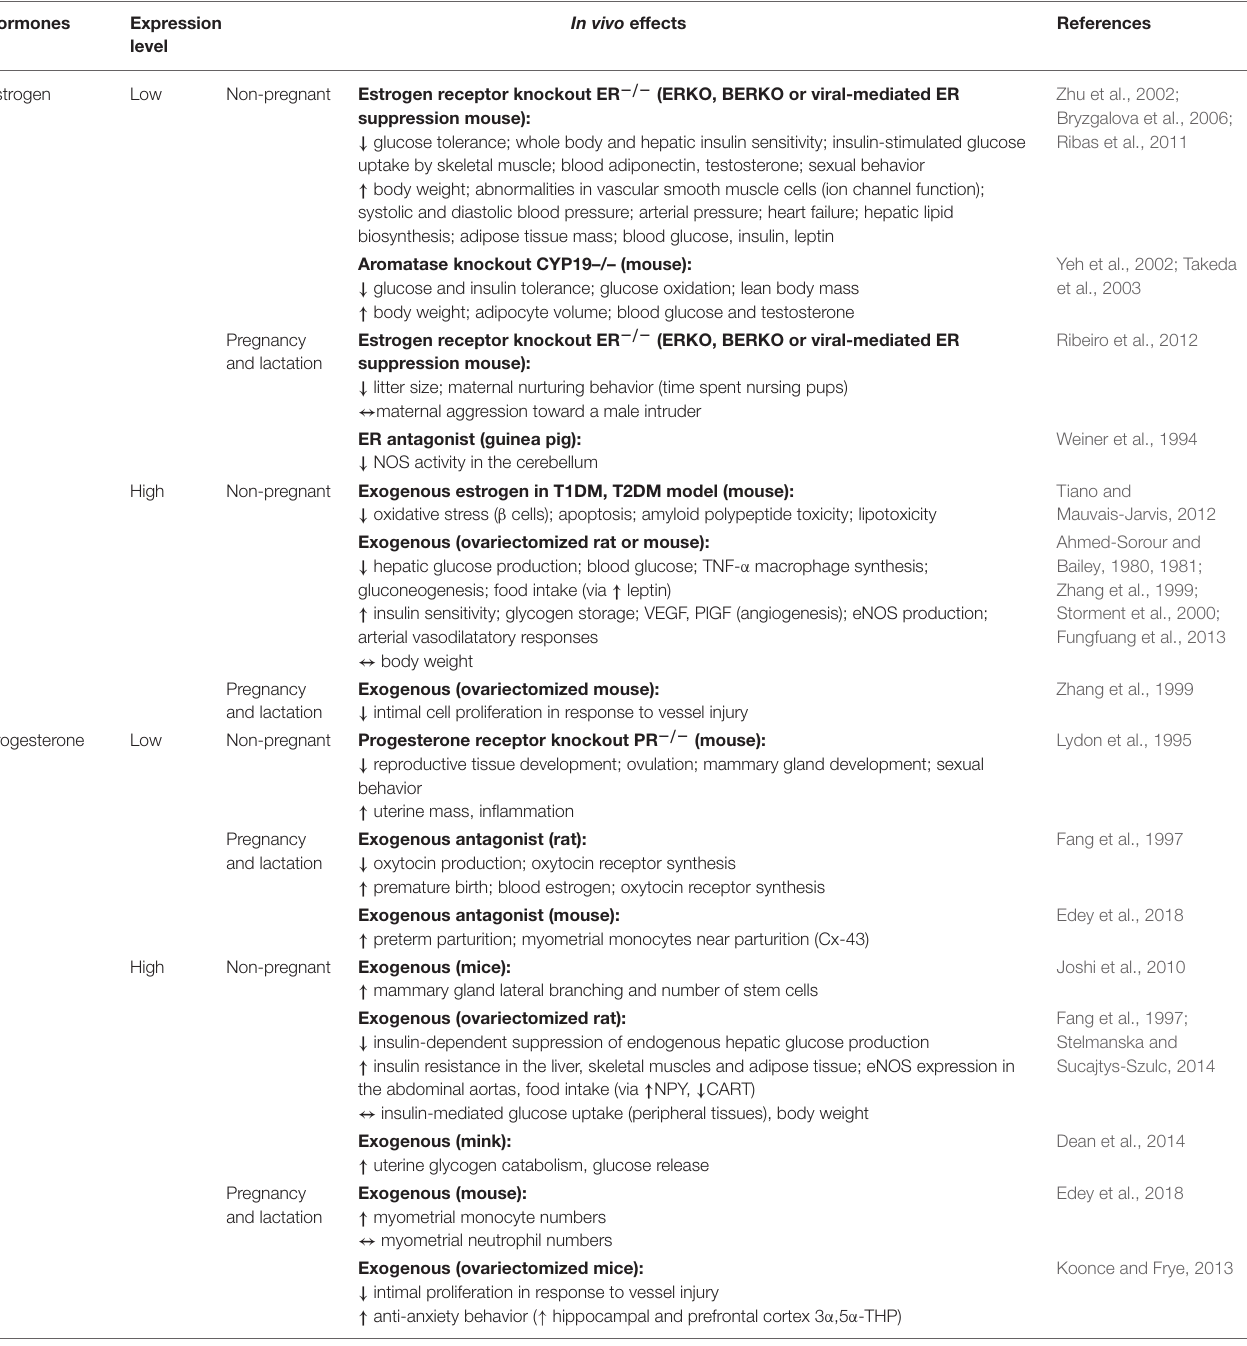
TABLE 3 | In vivo effects of steroid hormones in vivo